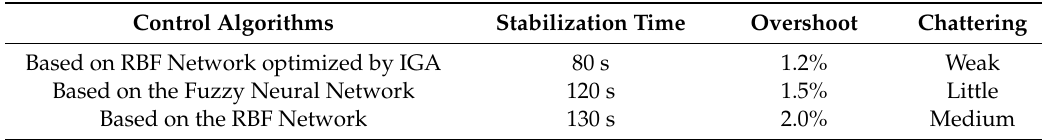
Table 3. The typical control performance indicators of the three algorithms.